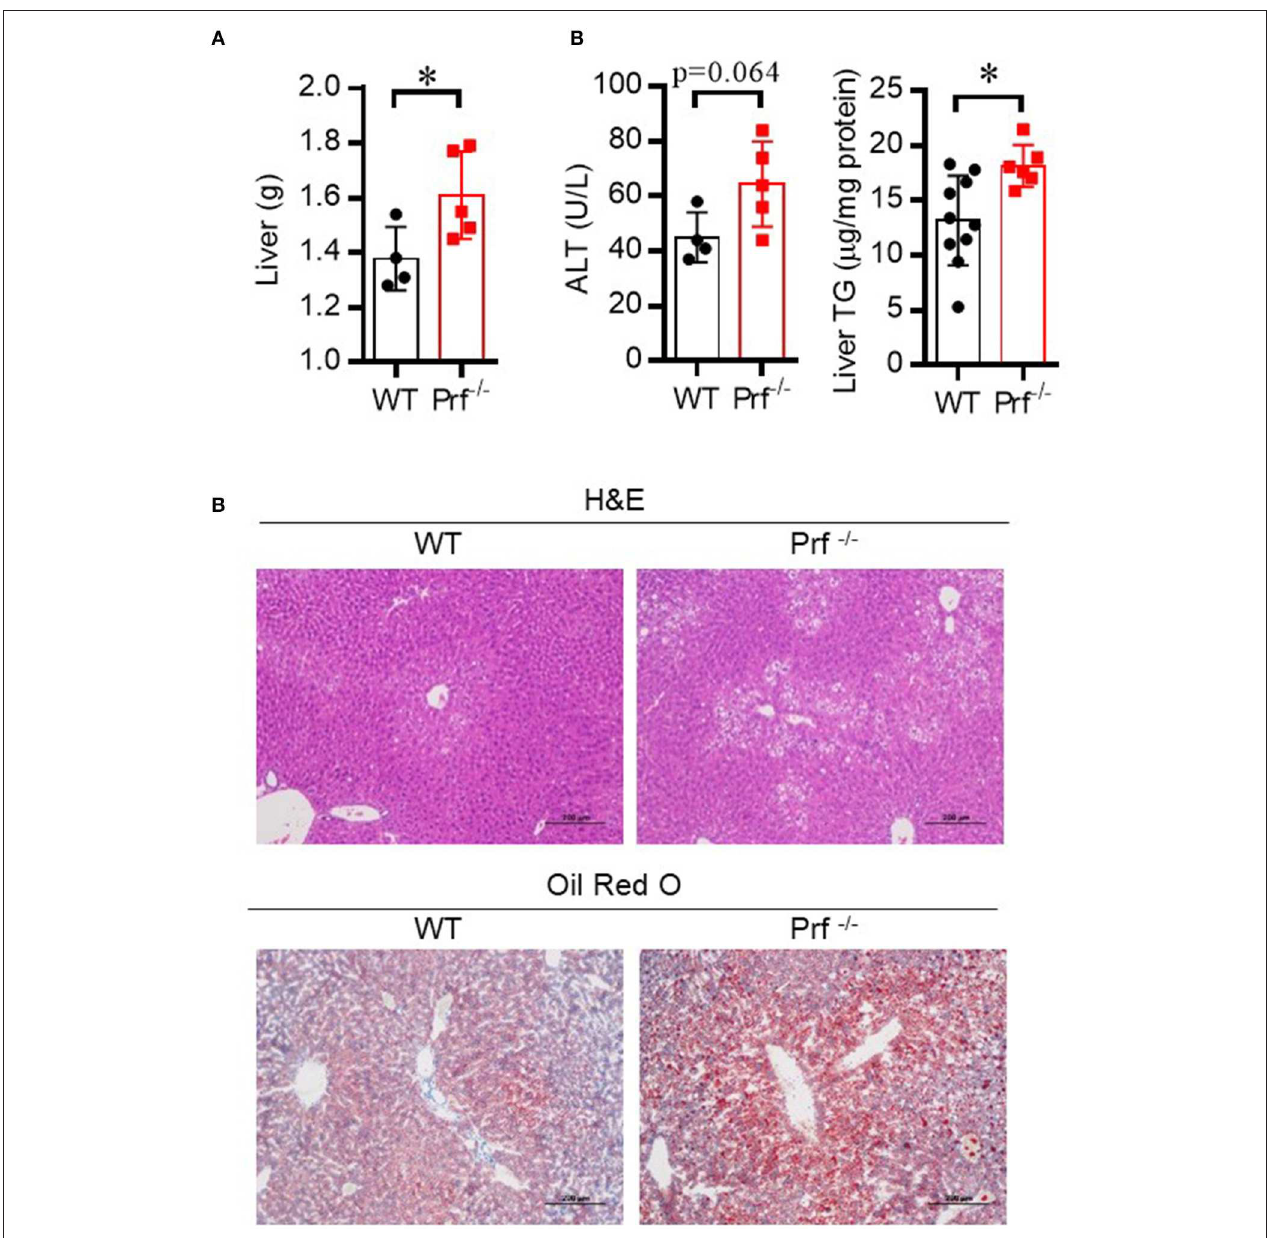
FIGURE 1 | Perforin deficiency accelerates liver injury and enhances lipid accumulation in 14 month-old mice. (A) Liver weight was determined for WT and Prf − / − mice on a normal chow diet ( n = 4–5). (B) Serum levels of ALT (left, n = 4–5) and liver TG content (right, n = 6–10) were measured. (C) Representative images of liver sections stained with H&E and Oil red O in WT and Prf − / − mice at the age of 14 months. ALT, alanine aminotransferase; WT, wild-type; TG, triglyceride. The data shown in each panel of the figures were collected from a single experiment, and each experiment was repeated for at least three times and rendered consistent results. Means ± SEM, * p <